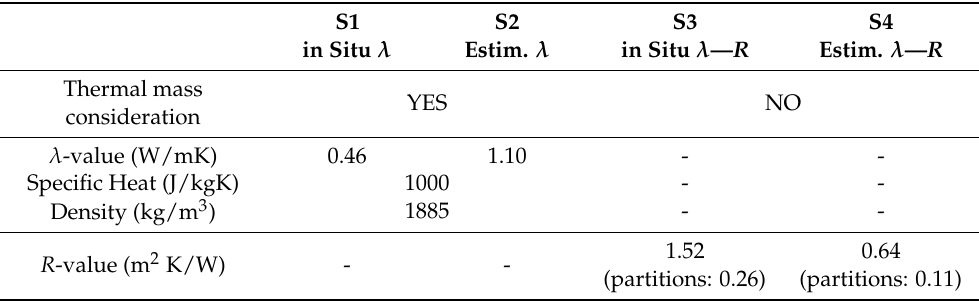
Table 3. Simulation alternatives: external walls and internal partitions 1.